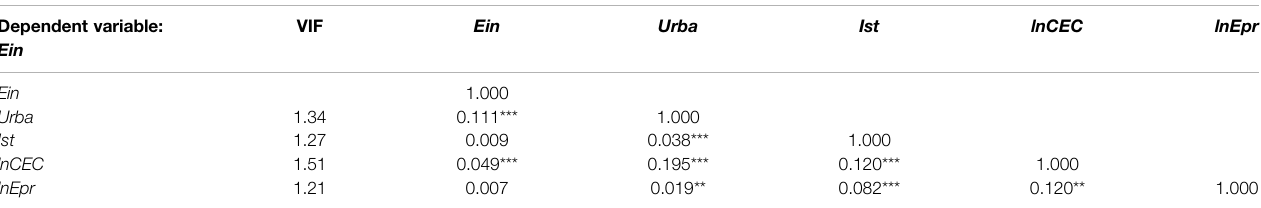
TABLE 4 | Correlation coef fi cient matrix and VIF tests for Ein